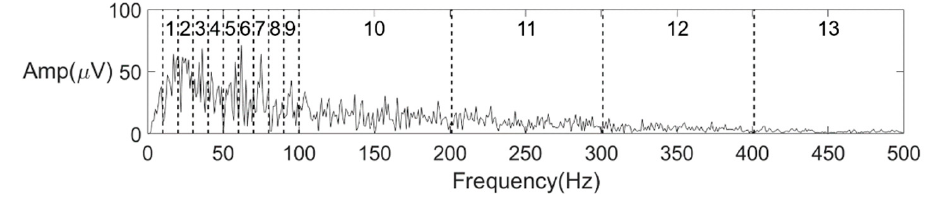
Figure 5. Interval division for features 1–13.